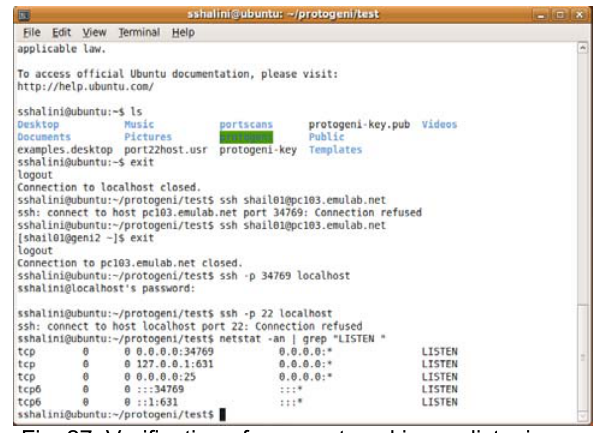
Fig. 27: Verification of new port working as listening port